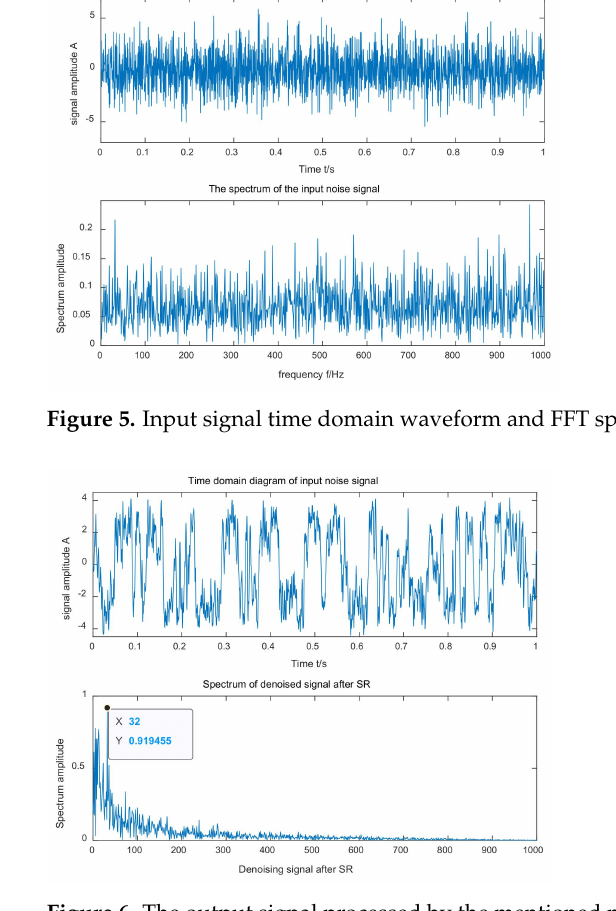
Figure 6. The output signal processed by the mentioned method of the simulation model.